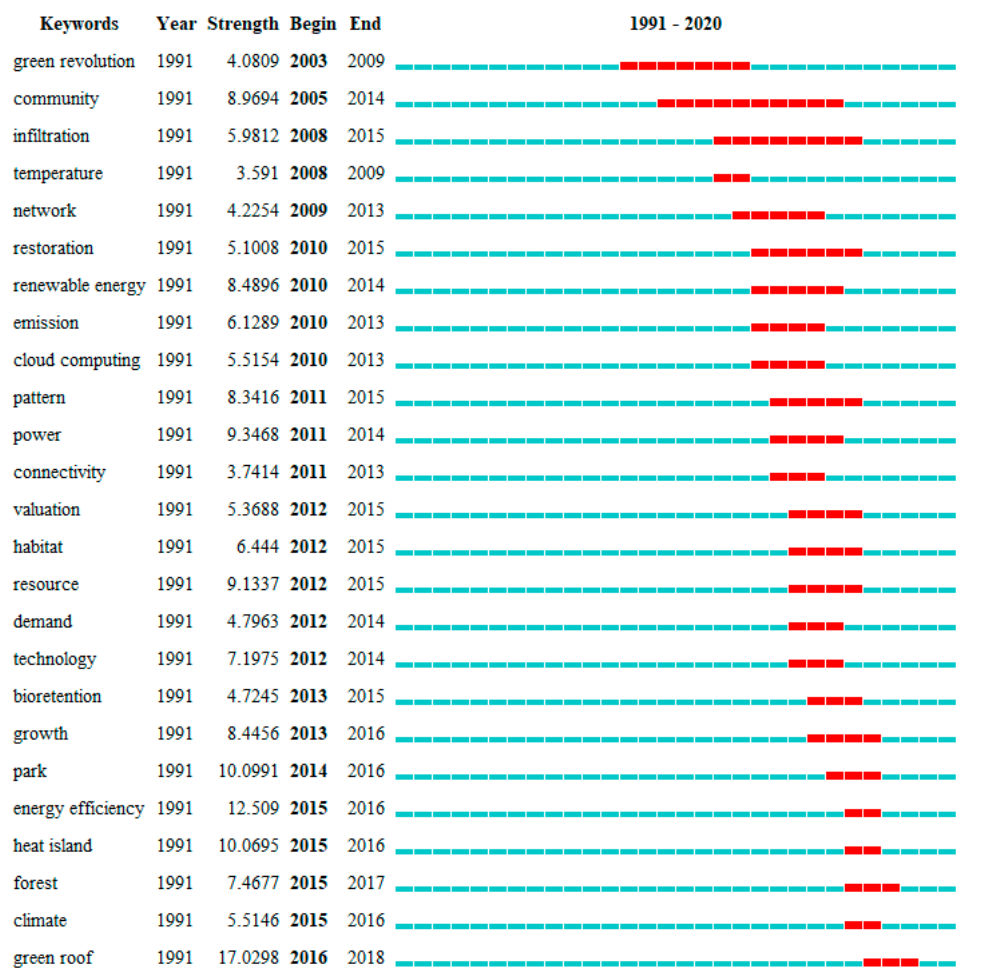
Table 2. Top 10 journals by number of publications.